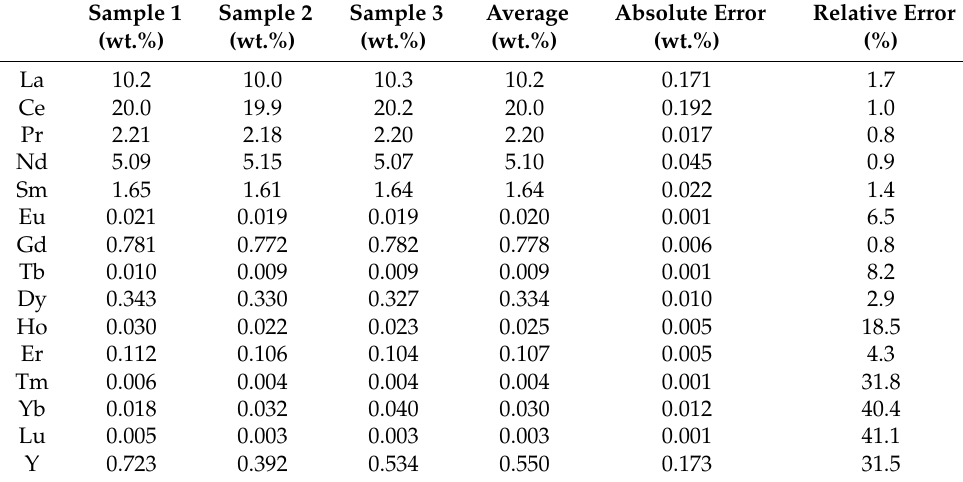
Table 2. Elemental composition: Assay of the Perth monazite using 3 g